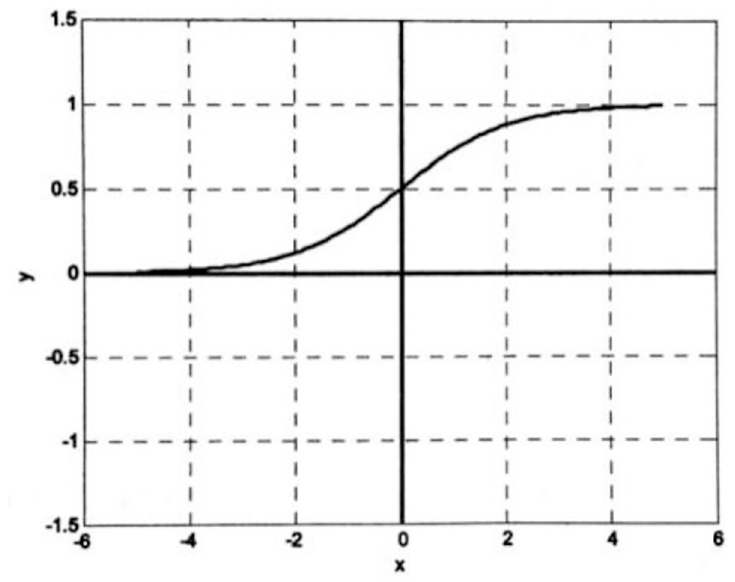
Fig 3. Log-Sigmoid